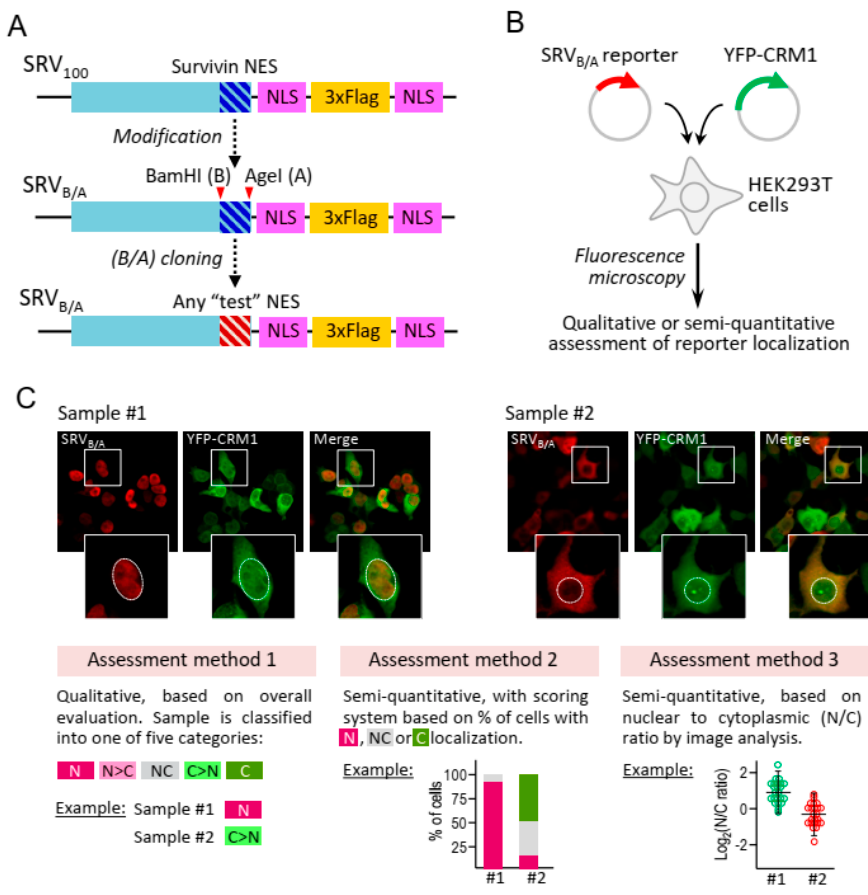
Figure 1. Description and use of the SRV B / A reporter with di ff erent assessment methods. ( A ) Schematic illustration showing the development and configuration of SRV B / A . This reporter is derived from the previously described SRV100 reporter containing the NES of survivin [19]. As originally described in a recent report [20], the plasmid encoding SRV100 was modified to introduce two novel restriction sites (BamHI / AgeI), which allows replacing survivin NES by any other NES motif. Besides a survivin amino-terminal fragment and the cloned NES motif, the SRV B / A reporter includes two copies of the SV40 NLS (PKKKRKV) separated by three tandem copies of the Flag epitope. ( B ) To carry out SRV B / A -based assays, HEK293T cells are co-transfected with plasmids encoding the reporter and the desired YFP-CRM1 variant. After anti-Flag immunostaining the localization of the reporter is determined using fluorescence microscopy. ( C ) Microscopy images show examples of the results of the assay with two reporters that contain di ff erent NES motifs. Insets show the magnified image of a single cell of each sample, with the nucleus delimited by a dotted line. Under the images, the three di ff erent methods used to manually assess the localization of the reporters in this study are described. Method